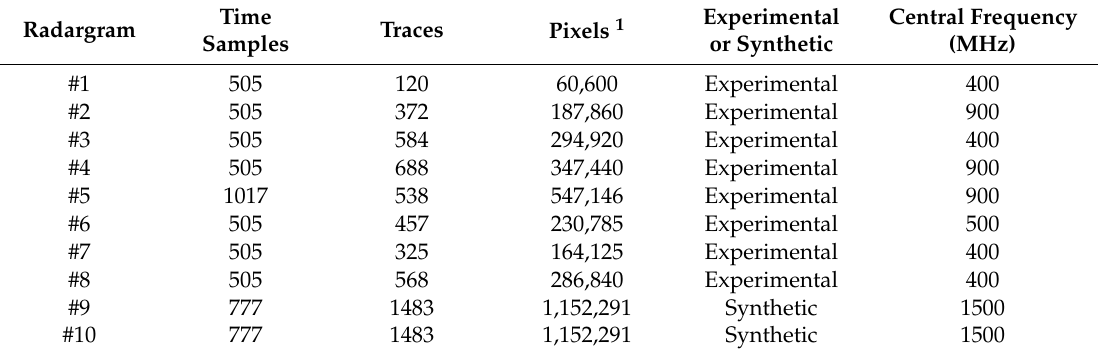
Table 1. Fundamental properties of the considered